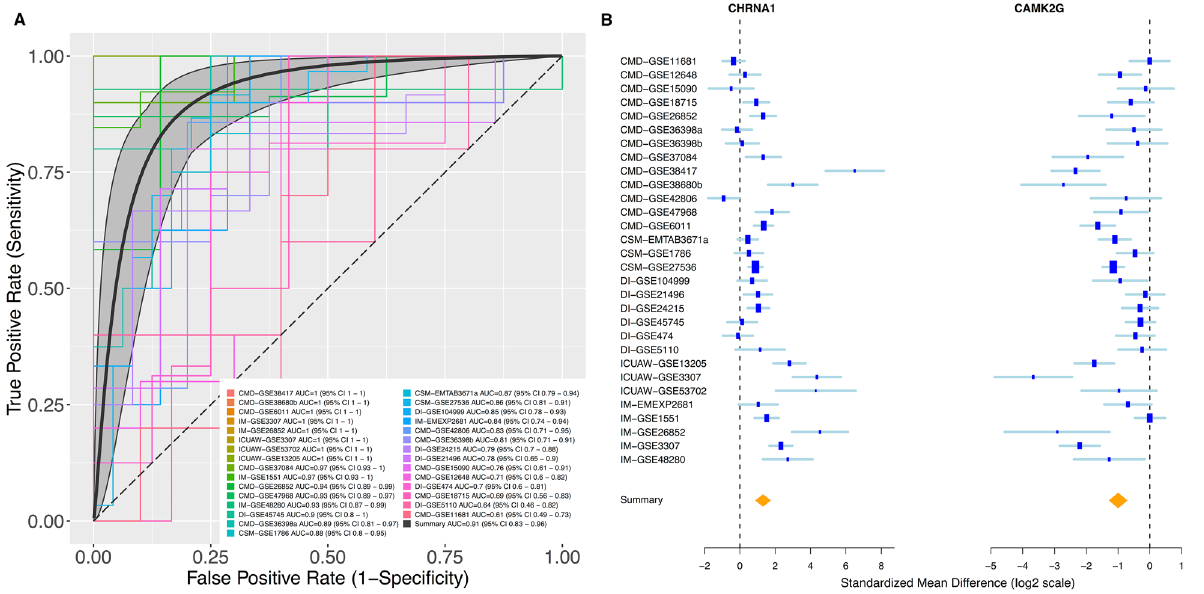
Figure 1. Discovery of the 52-gene signature expressed across human muscle diseases. ( A ) Meta-analysis and leave-one-disease-out analysis reveal common differentially expressed genes across muscle diseases. ( B ) Representative forest plots of most up-regulated (CHRNA1, left) and most-downregulated (CAMK2II, right) across muscle disease. The x axis represents standardized mean difference (Hedges’ g in z-scaled log 2 values) between muscle disease and controls. Summary effect sizes for each gene across all cohorts are represented as a yellow